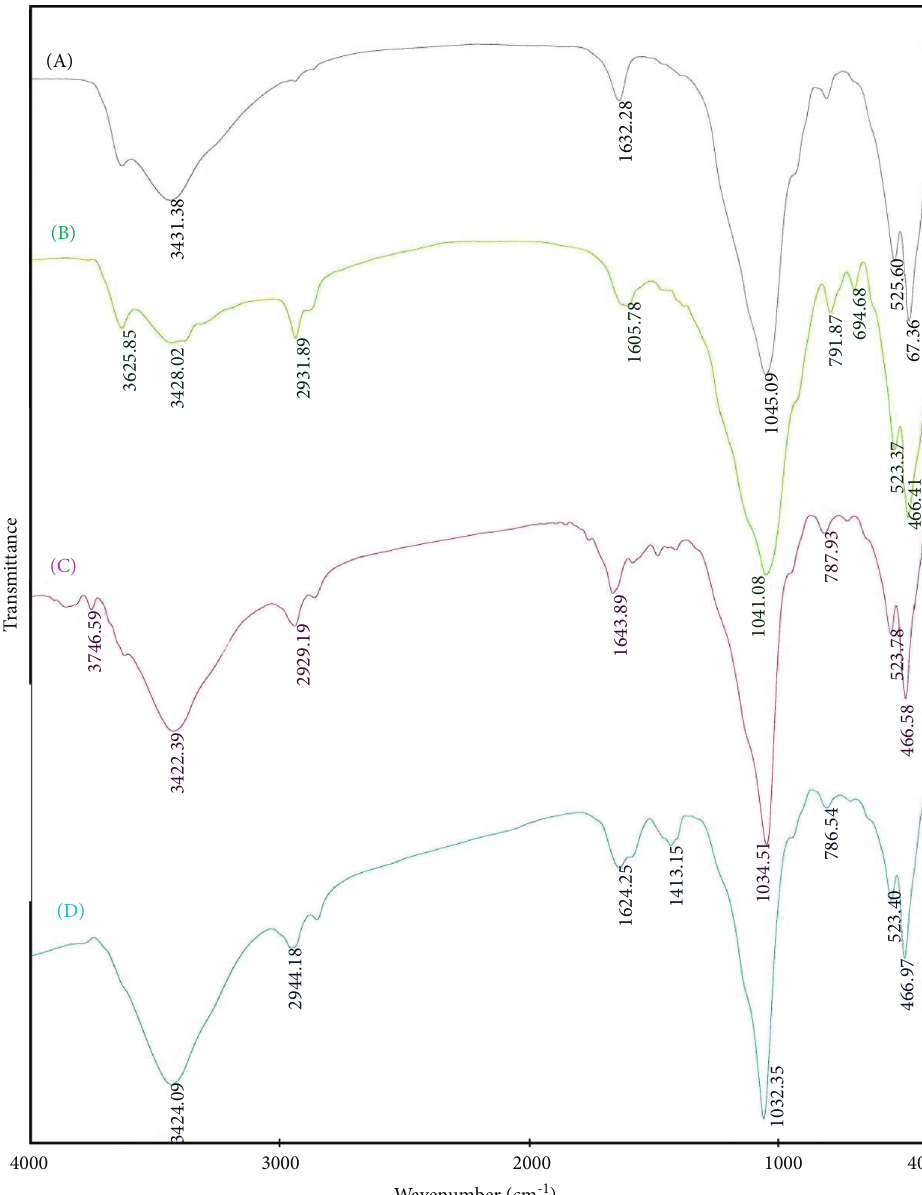
Figure 2: FTIR spectra of MMT K10 (a), MMT-[(CH